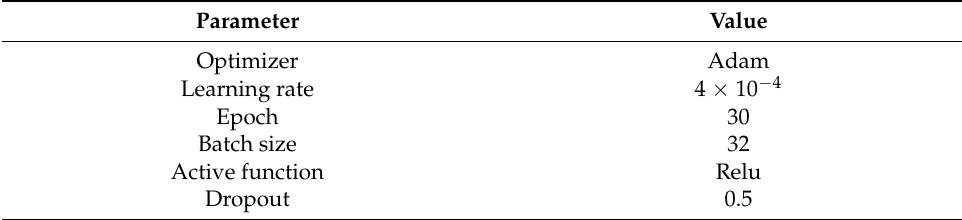
Table 2. Parameters of the